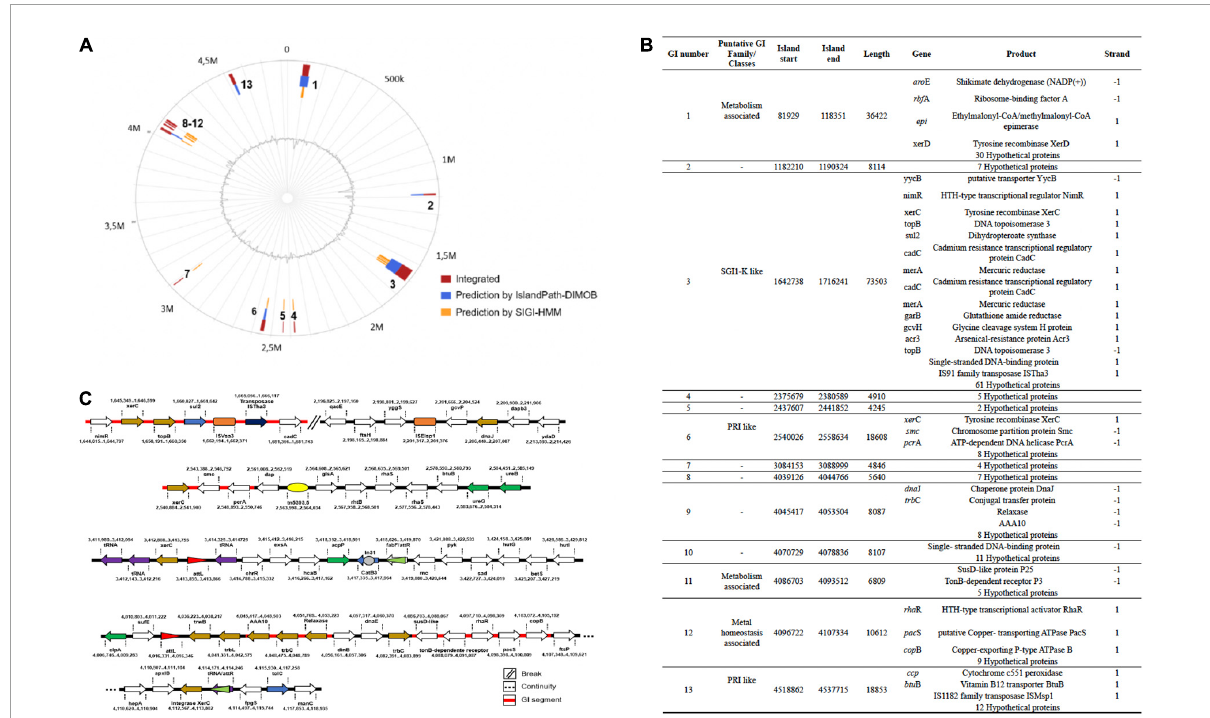
FIGURE7 Schematic representation of the Genomic Islands (GIs) and Mobile Genetic Elements (MGEs) in C. indologenes strain. (A) Circular genomic representation of GIs. (B) Genetic composition of the GIs. (C) MGEs found in C. indologenes . Arrow: Light blue (resistance genes), dark blue (transposase genes), golden [elements associated with Integrative and Conjugative Element (ICE)], green (virulence genes), purple (tRNAs). Red/green triangles represent the attL and attR sequences, respectively. Orange squares represent Insertion Sequences. The yellow ellipse represents transposons. The gray circle represents